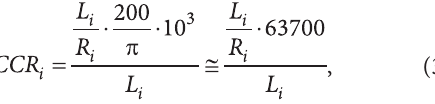
Fig. 5. Scheme of the principle of five-point cumulative angle calculation